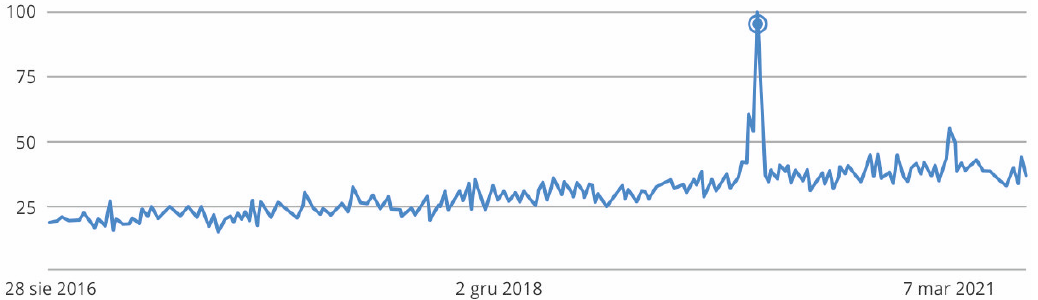
Figure 8. Frequency of searches for the keyword “prayer” over the last five years; source: Google Trends, https://www.google.com/trends (accessed on 23 August 2021).